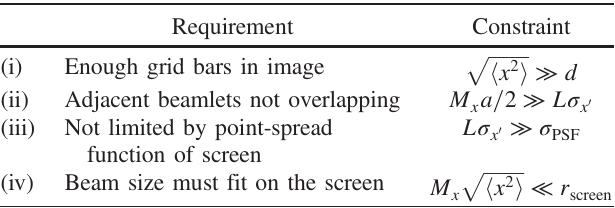
TABLE II. Requirements and constraints when making a measurement of a low-emittance beam with the TEM grid technique. L is the drift length from grid to screen; d is the grid bar spacing; a is the grid bar width; M is the horizontal x magnification; σ is the screen point-spread function; and r PSF